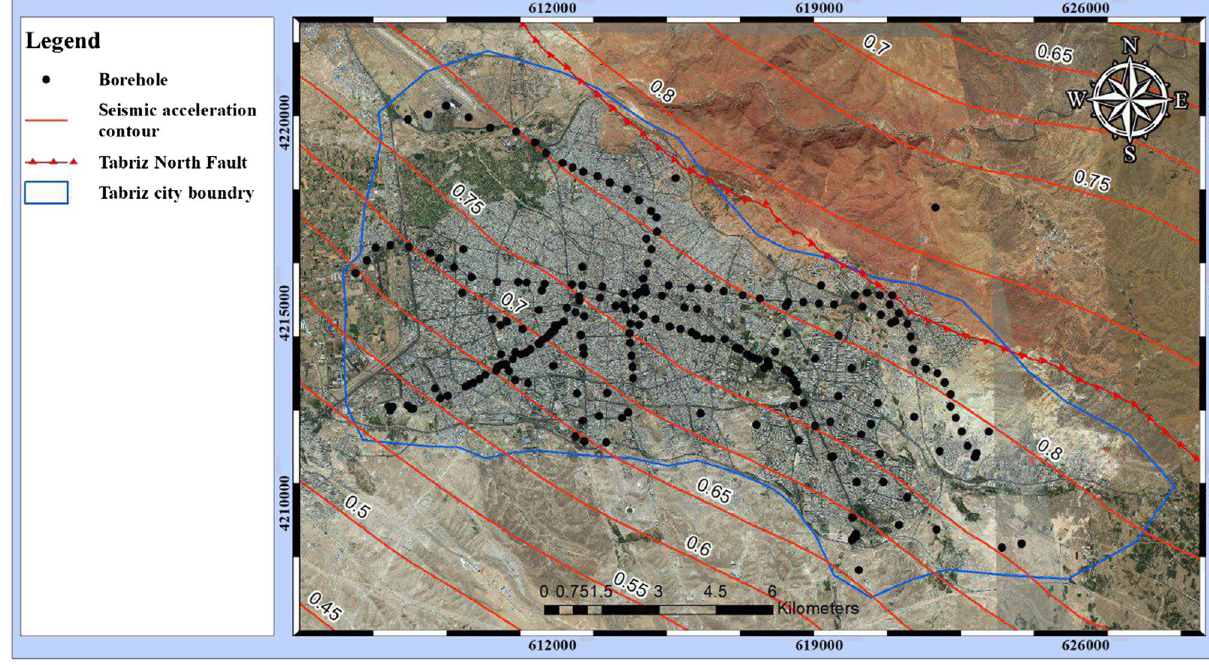
Fig. 7 The seismic zonation of Tabriz surface after amplification